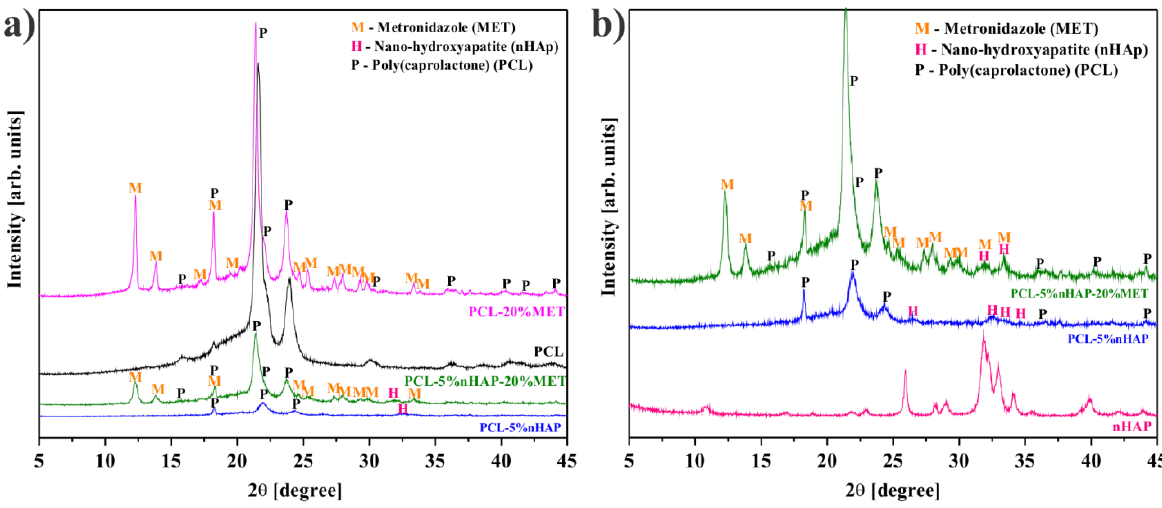
Figure 2. XRD patterns: ( a ) polycaprolactone (PCL), PCL-5% nHAP, PCL-20% MET and PCL-5% nHAP-20% MET; ( b ) nHAP synthesized, PCL-5% nHAP and PCL-5% nHAP-20% MET (to better highlight the presence of